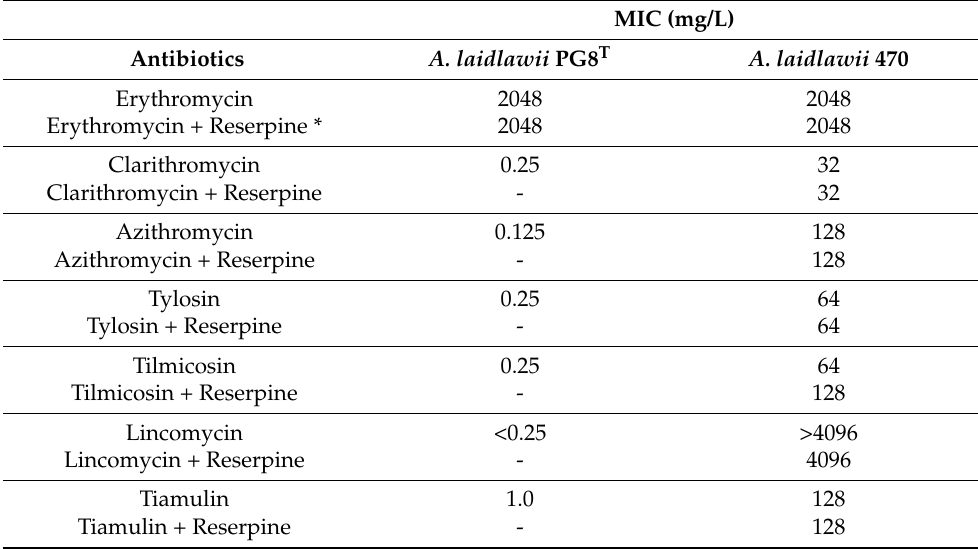
Table 1. MICs of macrolides, tiamulin and lincomycin in Acholeplasma laidlawii PG8T and in 470 without and with reserpine 20